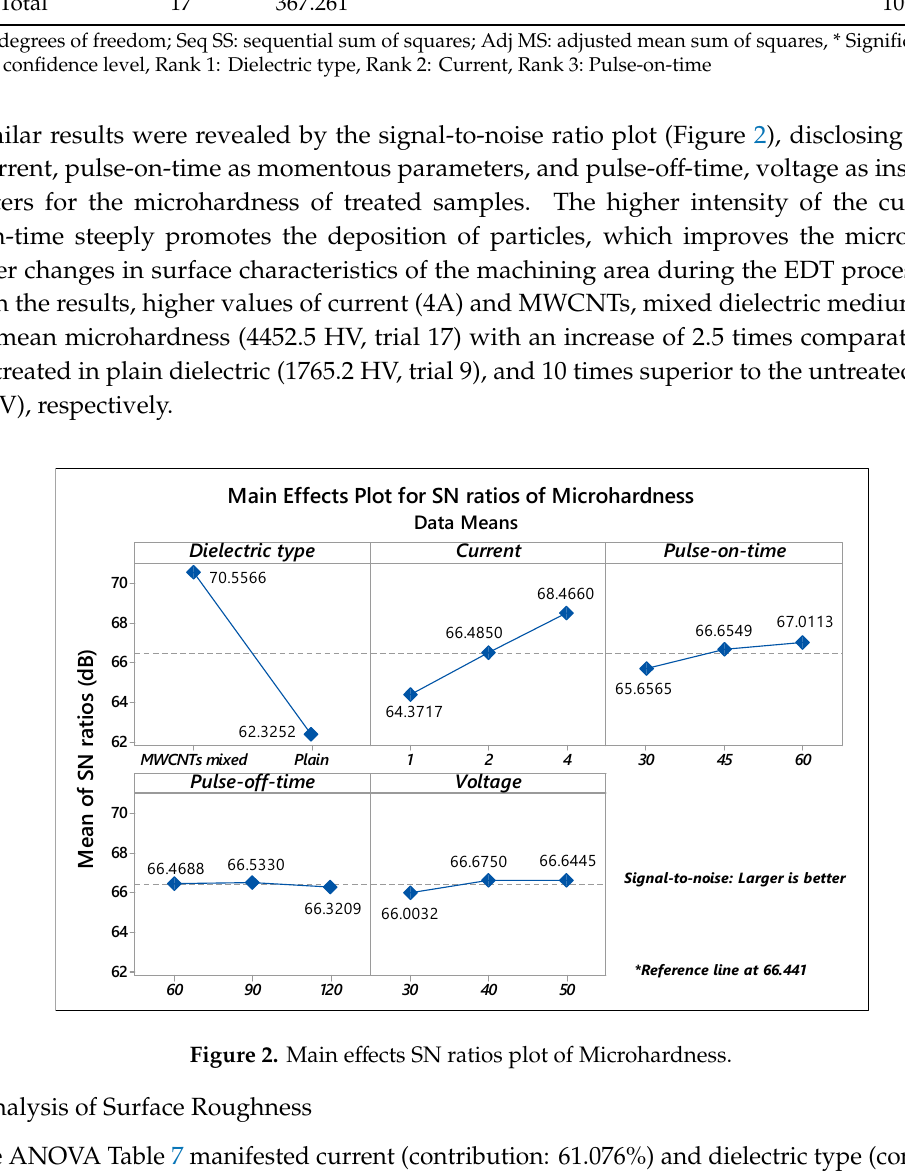
Table 6. Analysis of variance for signal-to-noise ratios of Microhardness.